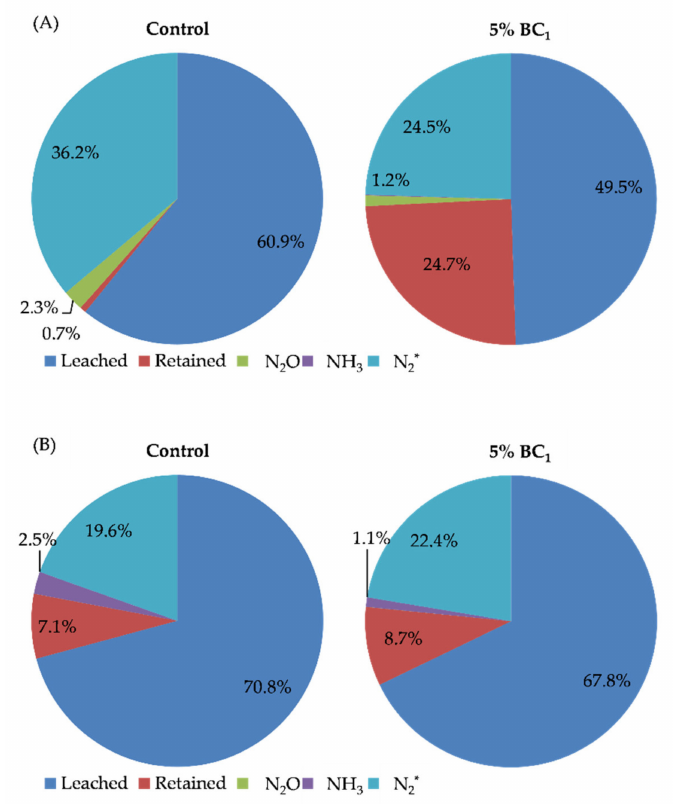
Figure 1. Cumulative mass of influent and e ffl uent nitrogen (N) (mg N) for control and biochar columns receiving ( A ) organic nitrogen (ORG-N) low (treatment group 1) and ( B ) ORG-N high (treatment group 2) application rates. Entire bar (with no fill) represents influent total nitrogen (TN), where entire solid bar represents e ffl uent TN. Individual N species in the e ffl uent are denoted based on color (blue, red, or green). Error bars represent standard deviation of e ffl uent TN between triplicate columns for treatment. Letters signify statistically significant di ff erence between treatments.